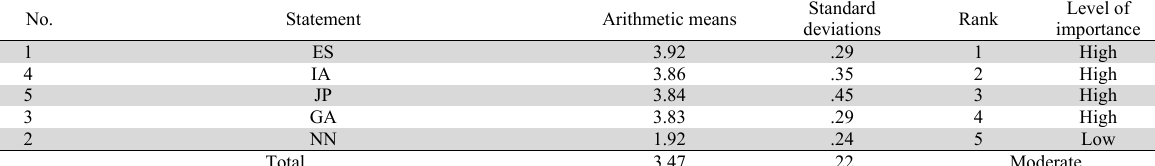
The arithmetic means and standard deviations of the questionnaire axes